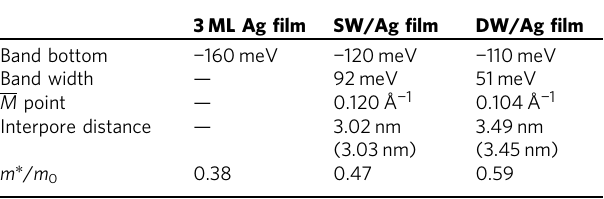
Table 1 Extracted ARPES experimental parameters from the bands presented in Fig. 3